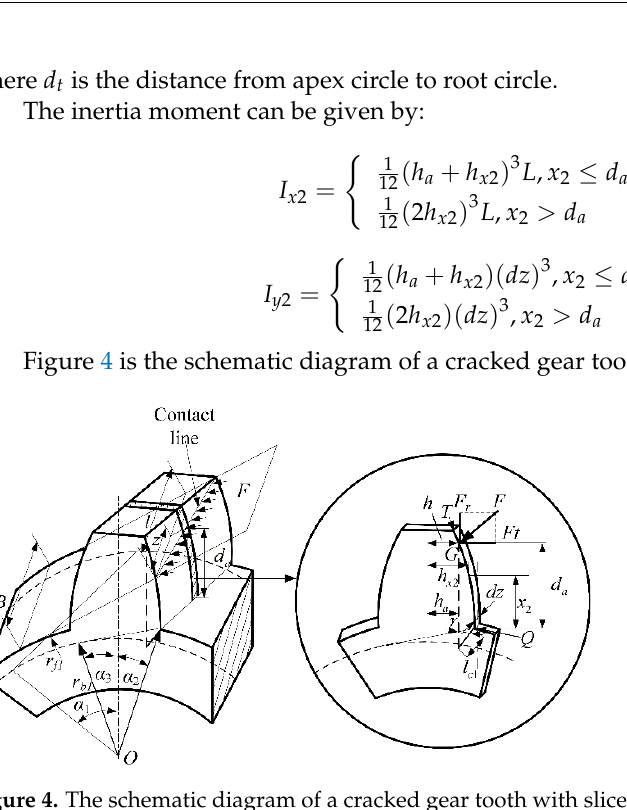
Figure 4. The schematic diagram of a cracked gear tooth with slice method.